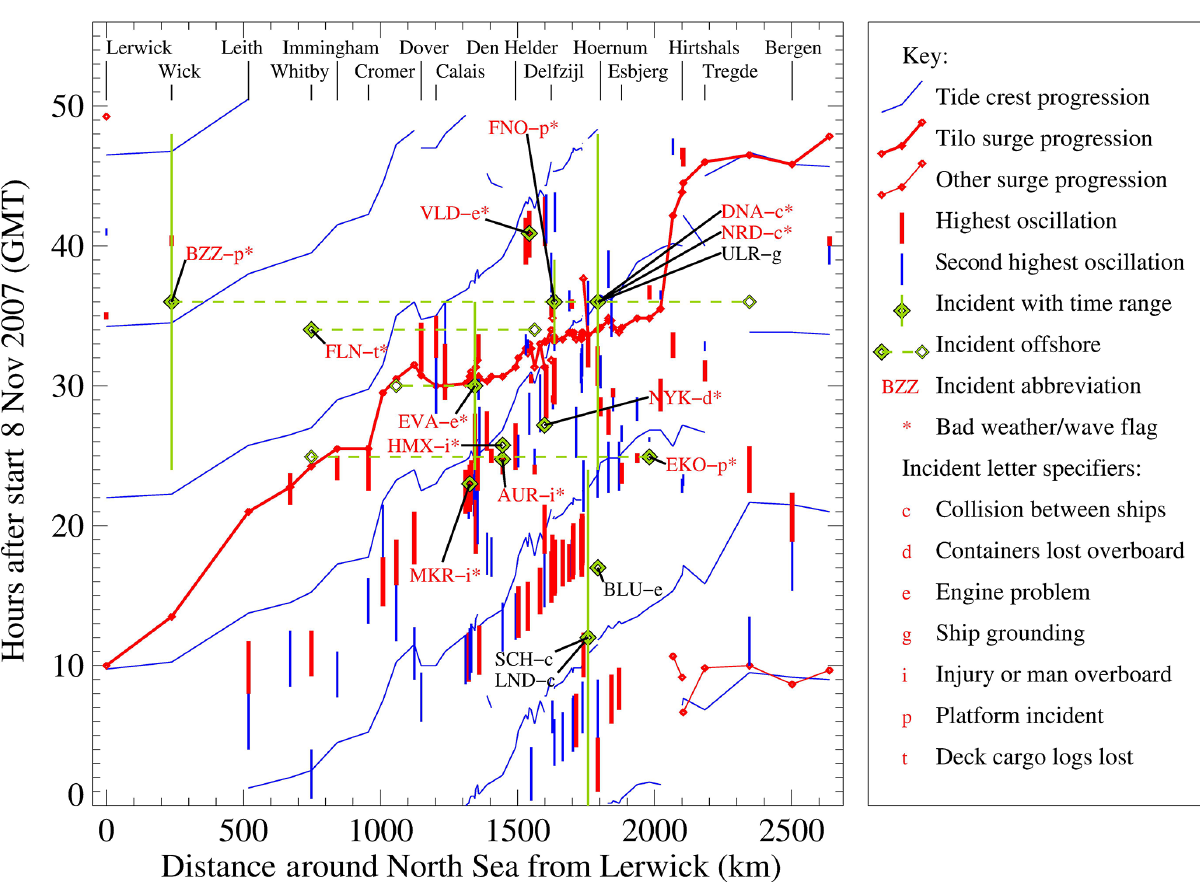
Figure 5. Relation between time and coastline distance around the North Sea during Storm Tilo on 8–9 November 2007 for the semi-diurnal tides, storm surge peak, highest two trough-to-peak heights of the down-crossing short period oscillations, and shipping/platform